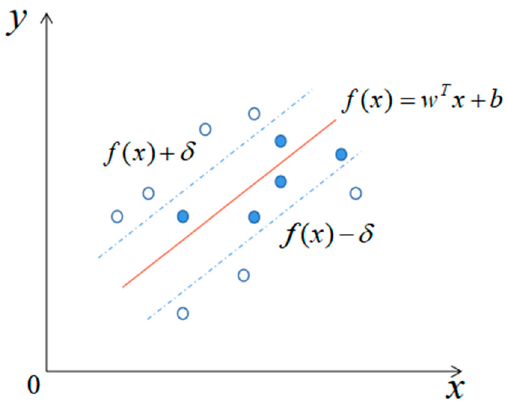
Figure 6. Schematic diagram of optimal hyperplane in support vector regression (SVR).